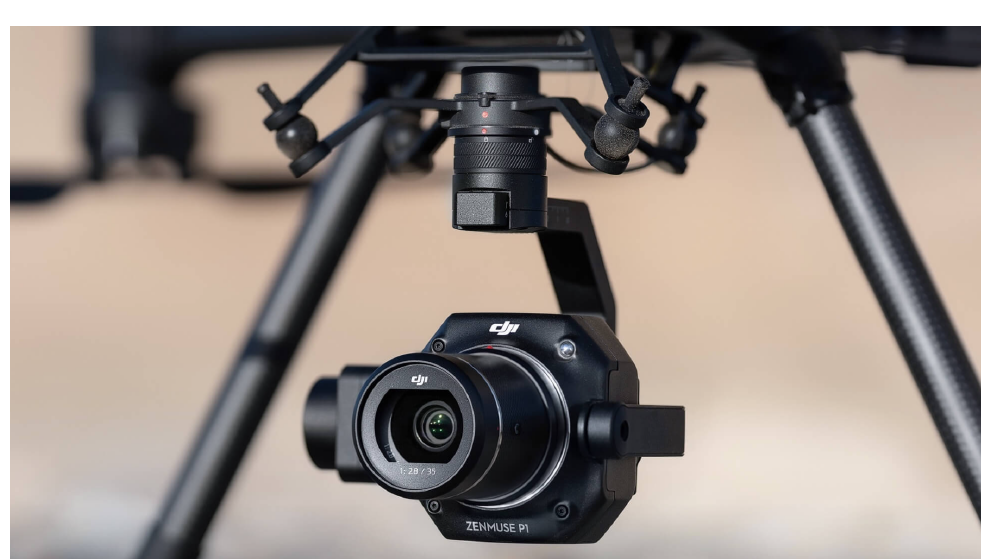
Figure 3. Zenmuse P1 sensor equipped with the 35 mm lens: the camera is anchored to the gimbal